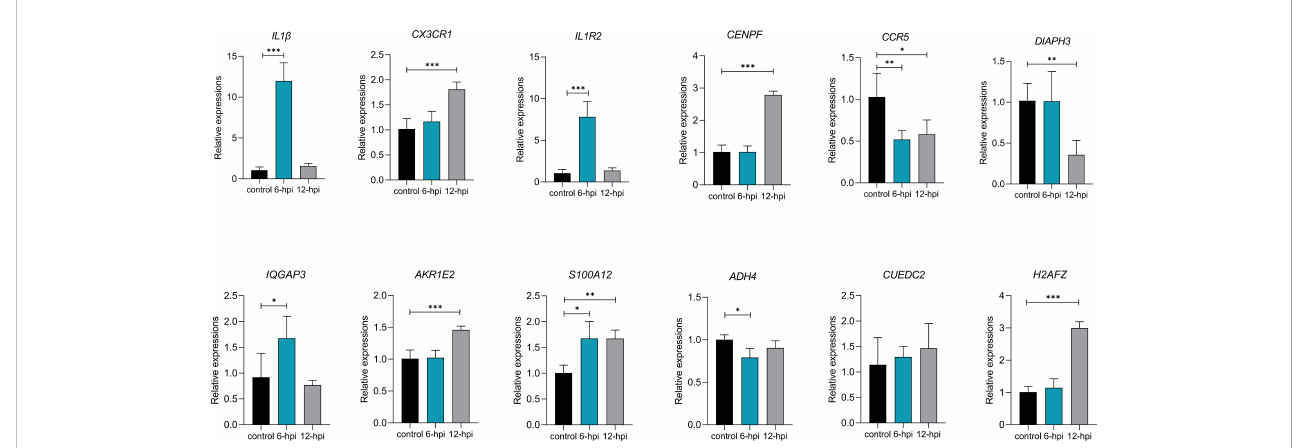
FIGURE 7 Some DEGs and hub genes mRNA expression after LPS stimulation in HD11 cells (n=3~6 per group). P < 0.05 (*), P < 0.01 (**) or P < 0.001